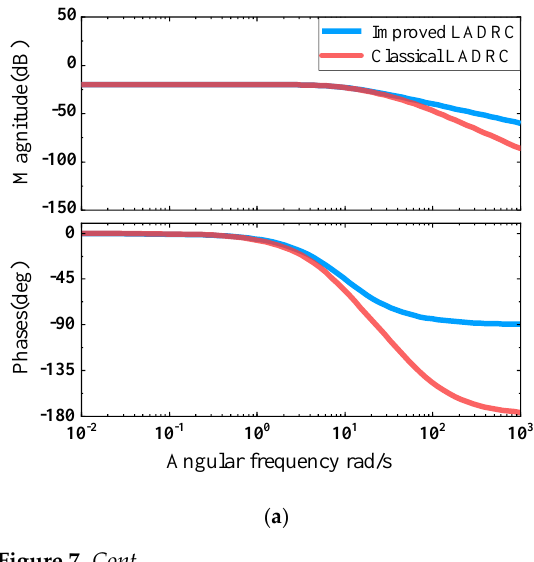
( b ) Figure 7. Improved LADRC tracking performance and antidisturbance porter diagram. ( a ) Im- proved LADRC and classical LADRC tracking performance Bode plot amplitude and frequency characteristics comparison analysis; ( b ) improved LADRC and classical LADRC anti-disturbance performance Bode plot amplitude and frequency characteristics comparison analysis. The Bode plot of the tracking performance of the LCL grid-connected system is shown in Figure 8a. The improved first-order self-turbulence controller LCL grid-con- nected system exhibited stable amplitude – frequency characteristics and a better pass- through performance with low- and medium-frequency signal inputs. Compared with the traditional LADRC phase frequency characteristics, the hysteresis angle was smaller, and the tracking performance showed a very good improvement. With the same bandwidth, the improved LADRC had a larger shear frequency than the conventional LADRC, which had a shorter convergence time and a faster response. As seen in the Bode plot in Figure 8b, the improved LADRC control exhibited more stable amplitude and frequency